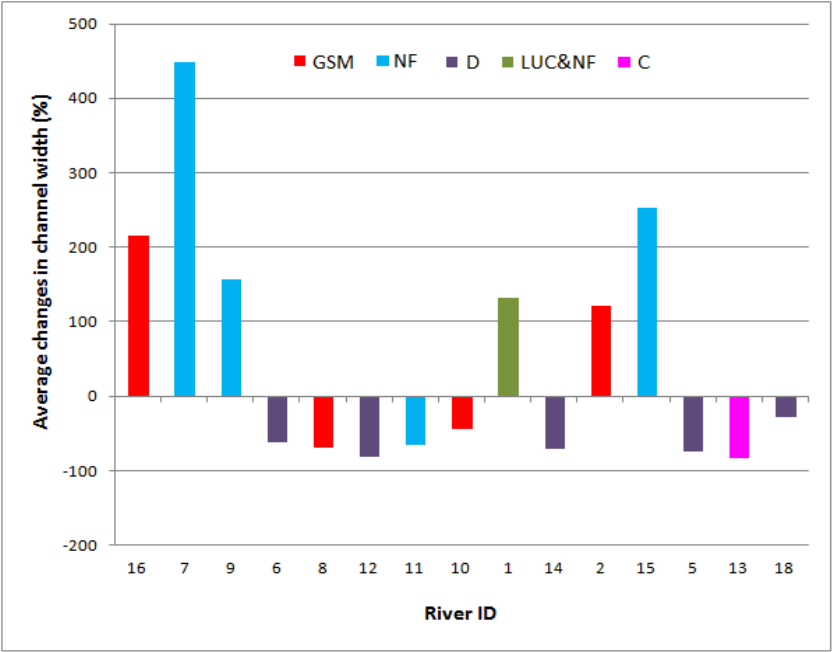
Figure 5. Changes in channel width and relative causes in Iranian rivers. GSM: Gravel and sand mining, NF: Natural factors, D: Dam, LUC&NF: Land-use change and natural factors, C: Channelization.